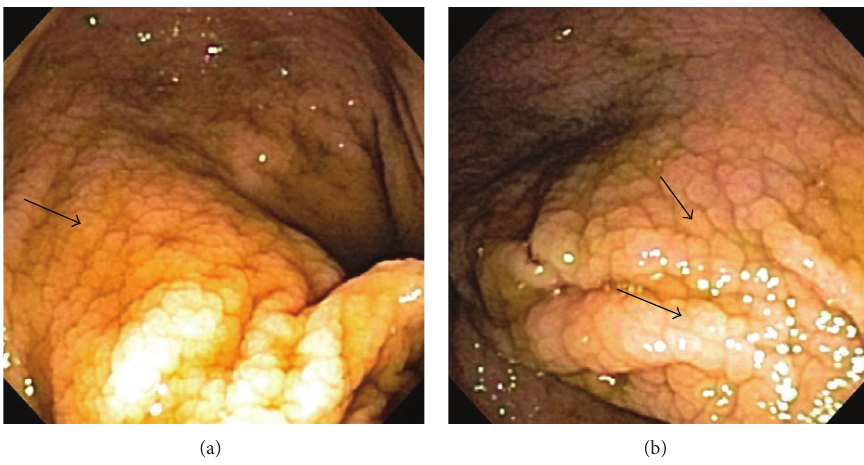
Figure 1: Colonoscopy images showing increased nodularity and loss of vascular markings.